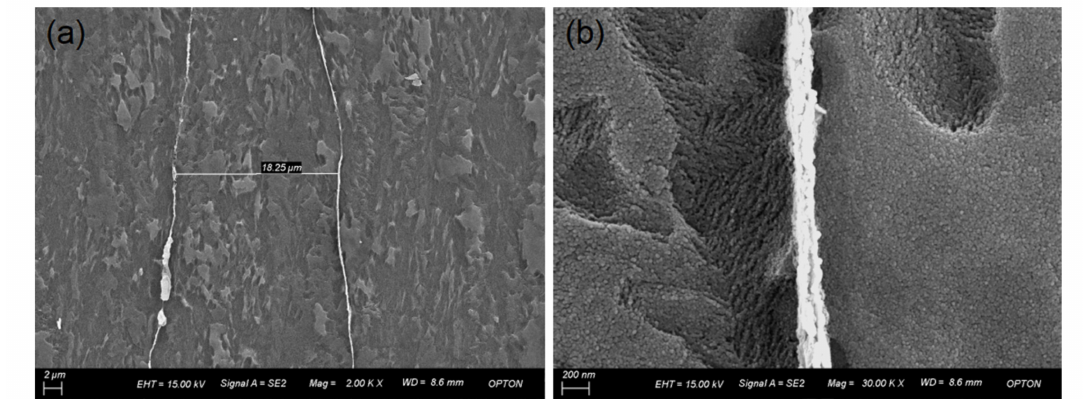
Figure 6. SEM micrographs of the EPD 8 min composites ( a , b ) corresponding magnified figure. Figure 7 displayed the typical XRD patterns of CNTs/Mg matrix composites with different EPD time, the profile for composite included peak which corresponded to the Mg phase. The peaks of Mg–C could not be clearly identified, which indicated that there was no reaction between Mg and C.